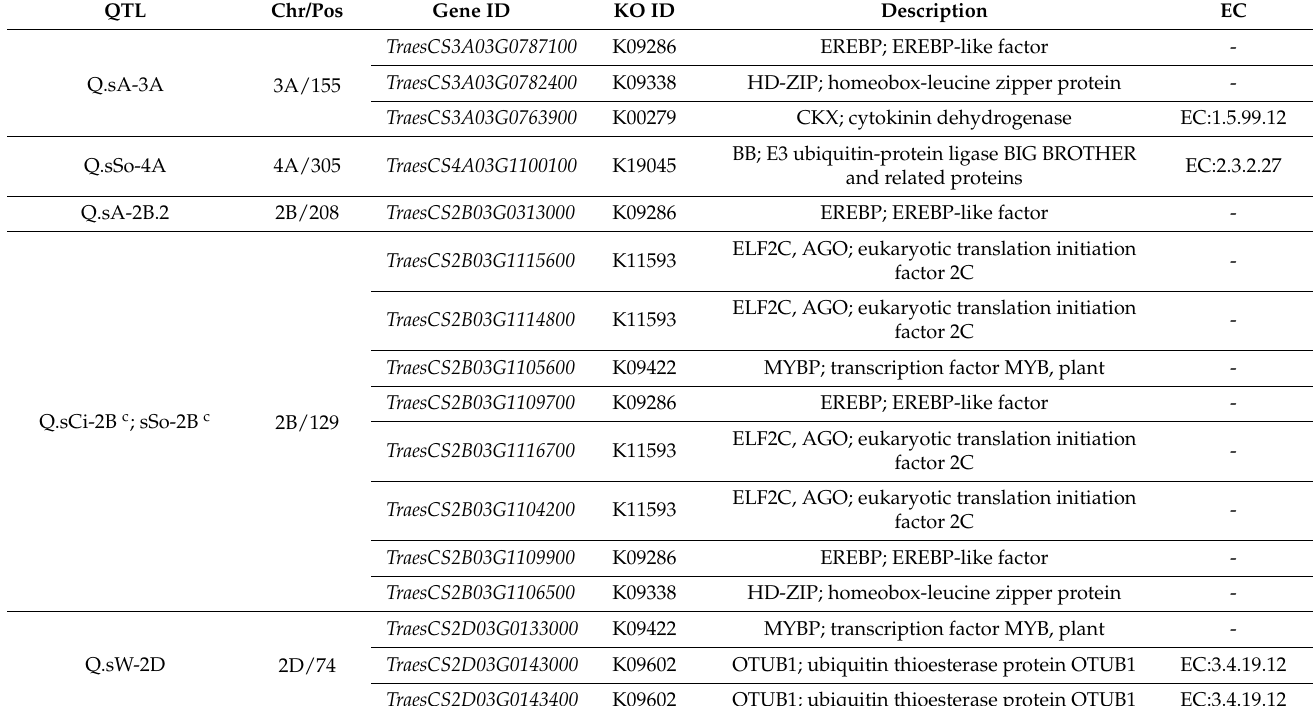
Table 1. List of candidate genes from QTLs associated with seed size/shape. Columns of the table contain QTL name (QTL), chromosome and position in cm (Chr/Pos), gene ID, KEGG orthogroup ID, KEGG orthogroup description, and EC number, if